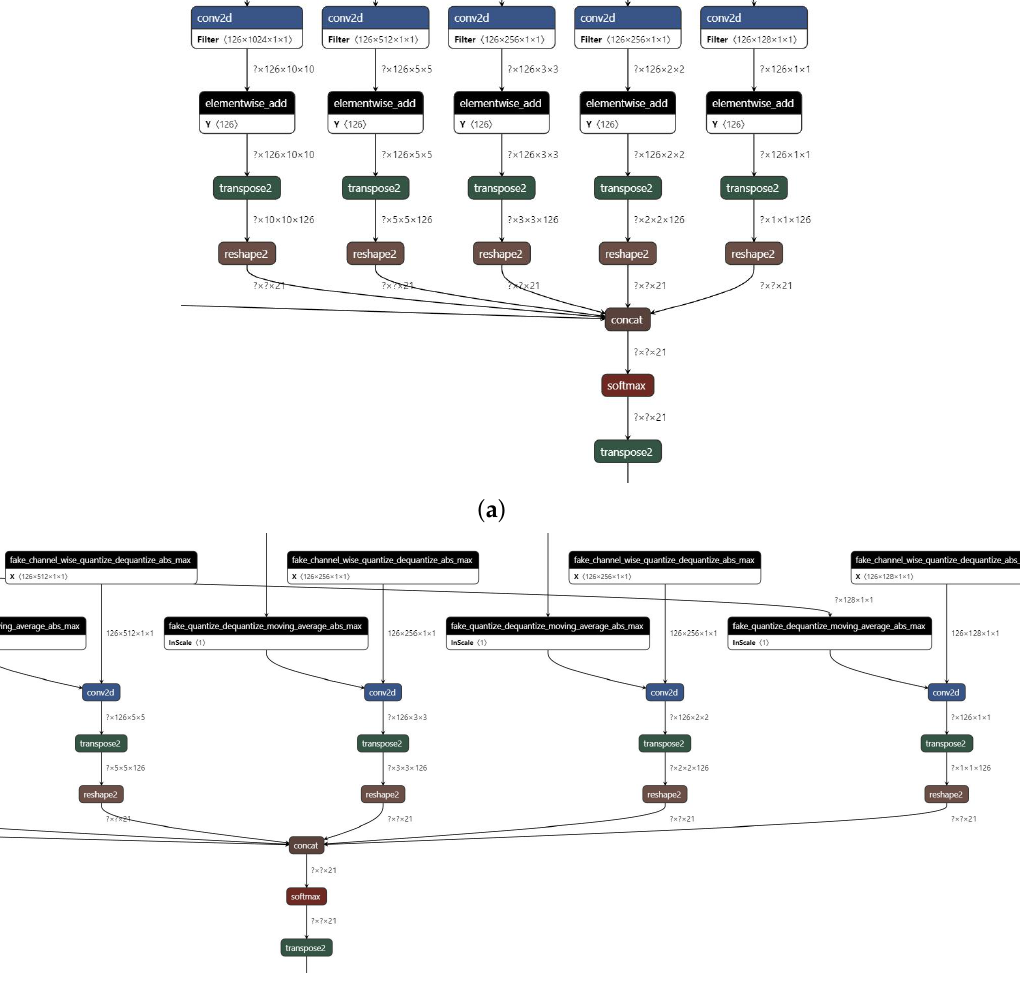
Figure 14. Comparison of head network before and after quantization ( a ) Before quantization. ( b ) After